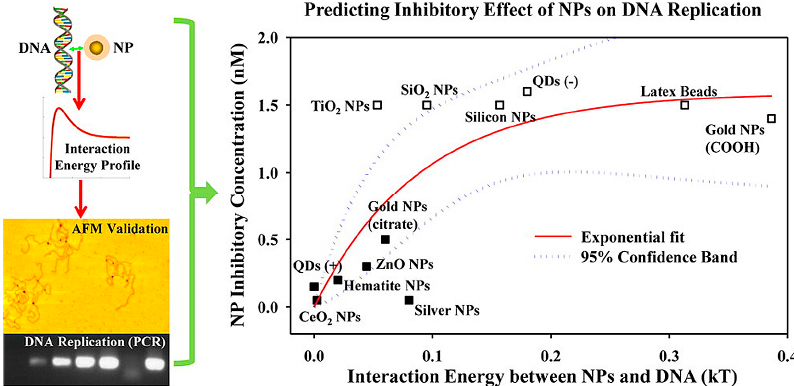
Figure 4. Relationship between the tested concentration of NPs significantly inhibiting DNA replication in vitro and the determined energy barrier between NPs and DNA (reprinted with permission from [258], Copyright American Chemical Society,